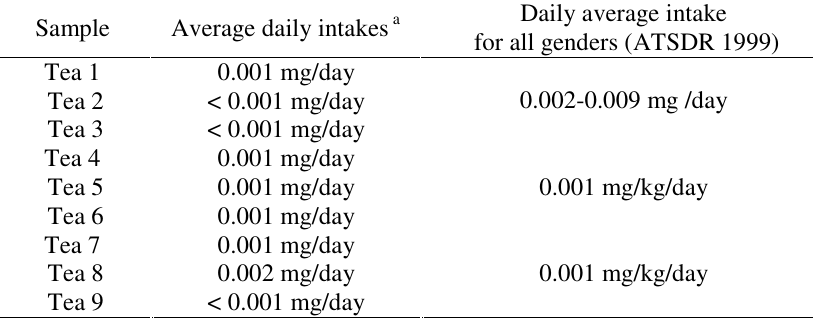
Table 5. Average daily intakes of lead from green tea infusions Sample Average daily intakes a Tea 1 0.001 mg/day Tea 2